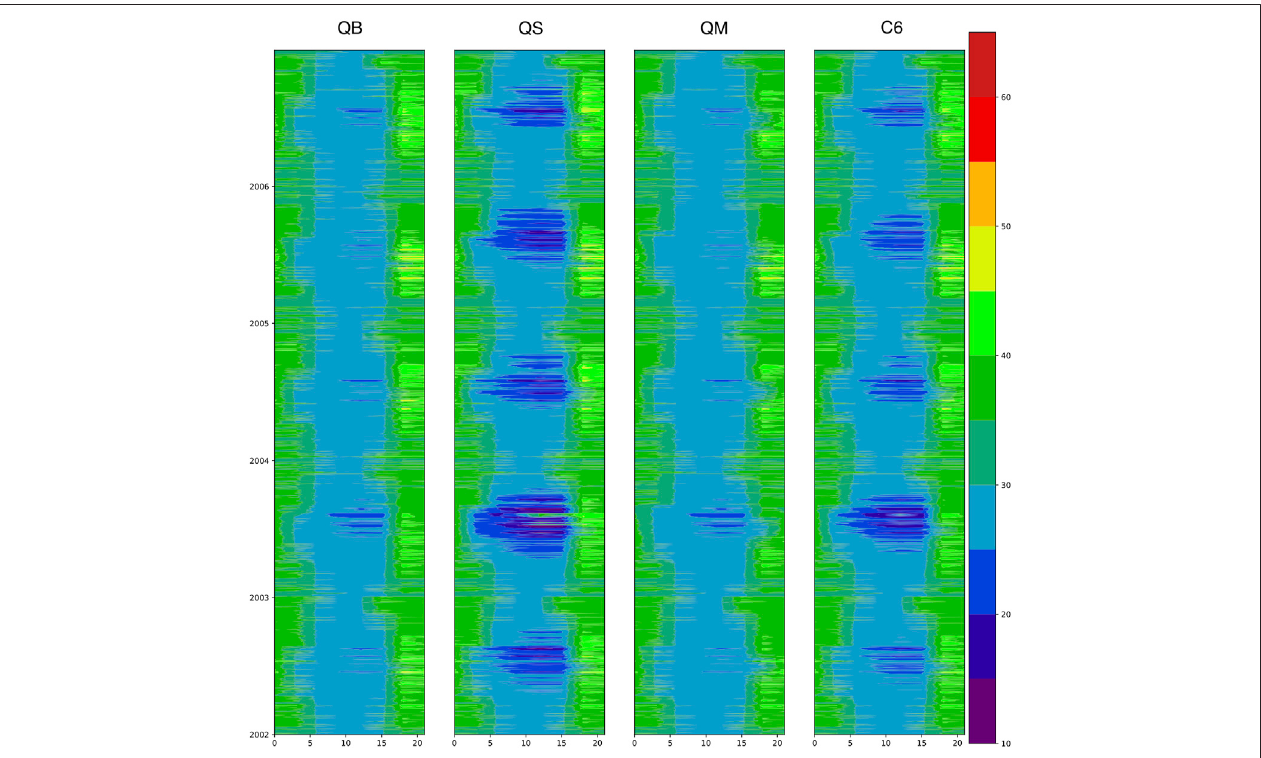
FIGURE14| ThediurnalandseasonalevolutionofinternalCO 2 pressure(C i ,Pa)as fi lledcontours fortheJULESPlantFunctionalType1(BroadleafTrees)atagrid point inFrance. Thediurnalcycle(GMT hour) isshown onthe x axis,whiletheseasonal cycle(indicated byyearsfrom 2002to2006,top) isshown onthe y axis.Thefour experiments are QB, QS, QM, and C6 in each